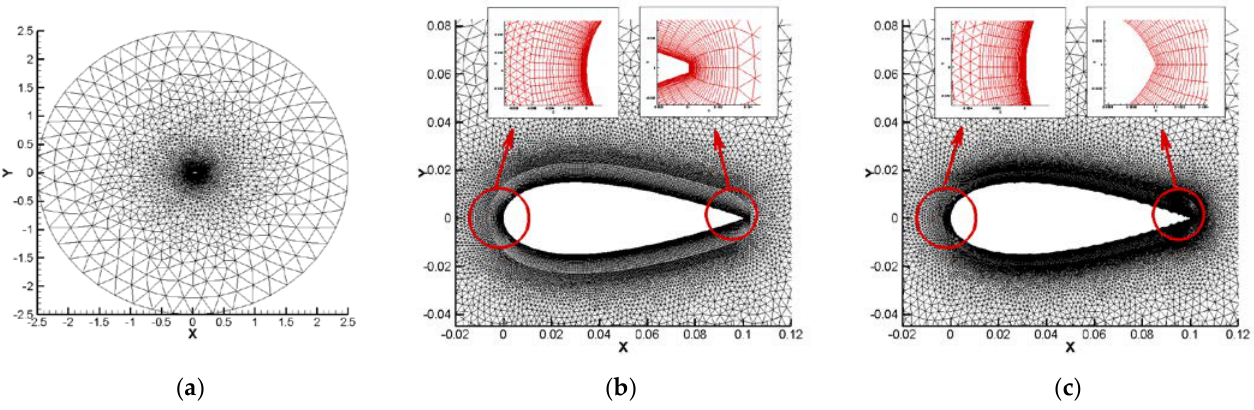
Figure 3. Computational grid distribution at different positions: ( a ) Far-field, ( b ) Boundary layer of NACA0030, and ( c ) Boundary layer of a corrugated airfoil (Corrugated 14).